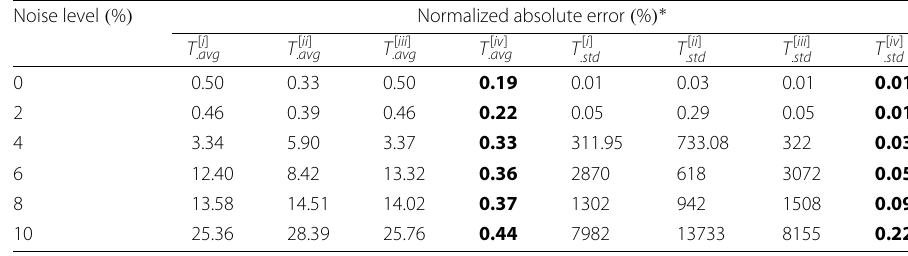
Table 1 The means and standard deviations of NAE L of the four algorithms Noise level ( % ) Normalized absolute error ( % ) ∗